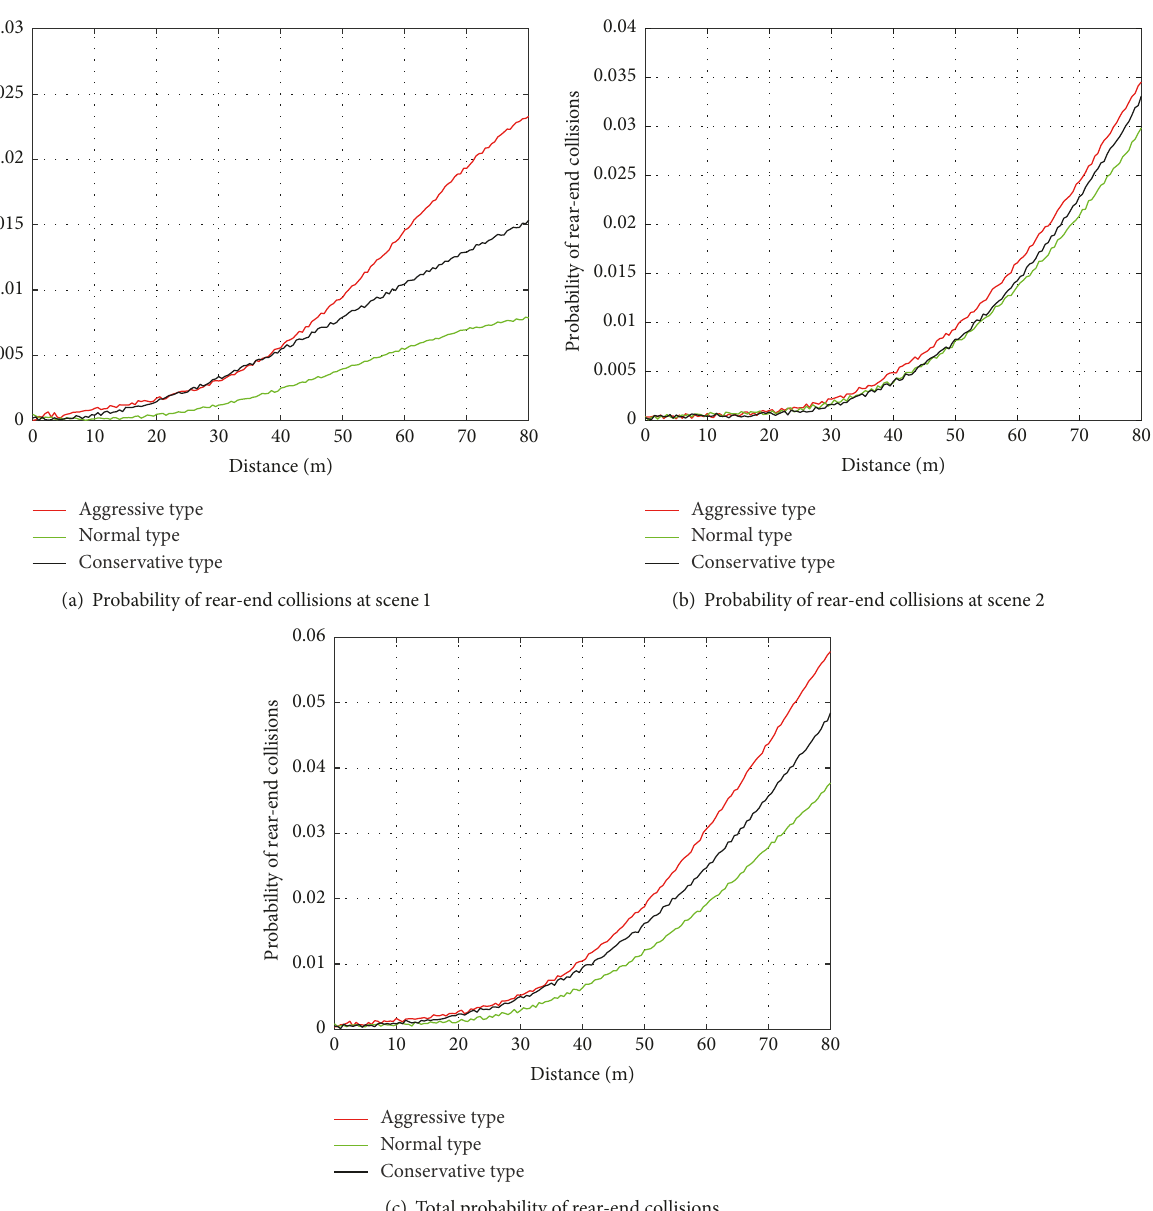
Figure 4: Simulation results of rear-end collision